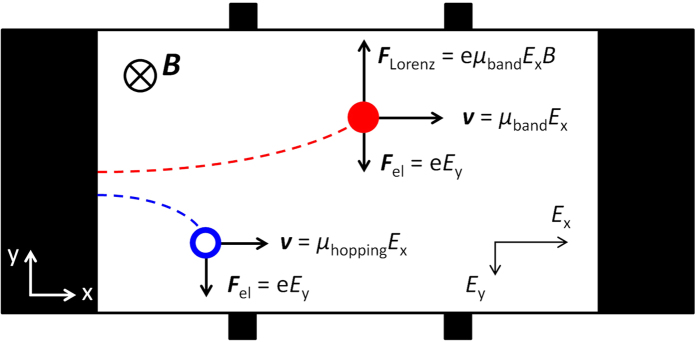
The two types of charge carriers (both holes) in organic semiconductors with disorder: a coherent band-like hole moving in delocalized states (solid red circle) and a hopping hole moving in localized tail states (open blue circle).In Hall effect measurements, these carriers are skewed towards the opposite sides of the channel, because the band carriers experience both the Lorentz and electric forces, while the hopping carriers only respond to the electric forces. The motion of hopping carriers in the transverse direction leads to a (partial) compensation of the Hall voltage, which results in underestimated mobility and overestimated carrier density in Hall effect measurements, as compared to those obtained in longitudinal FET measurements (μHall < μFET, nHall > nFET).